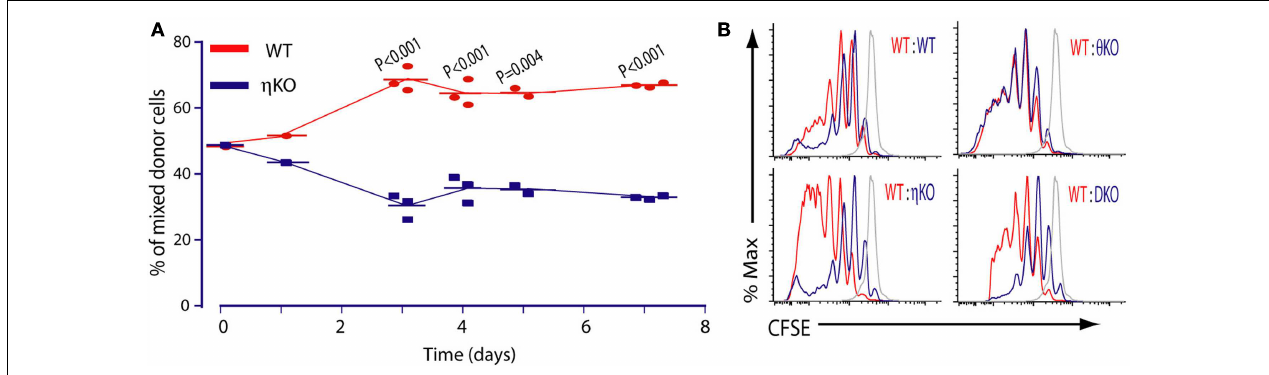
FIGURE 5 | Requirement of PKC η inT cell proliferation. (A) PKC η is required for efficient antigen-specificT cell proliferation in vivo . (B) PKC η but not PKC θ is required forT cell homeostatic proliferation in vivo . Adapted from Fu et al. (2011).